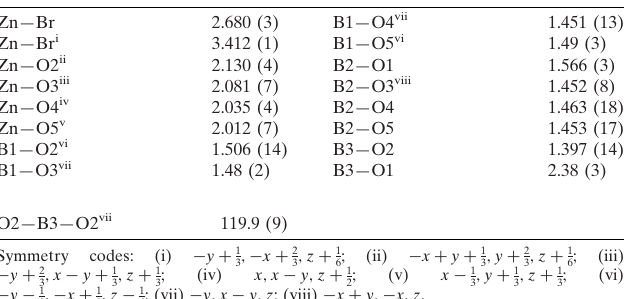
Selected geometric parameters (A˚ , (cid:3)